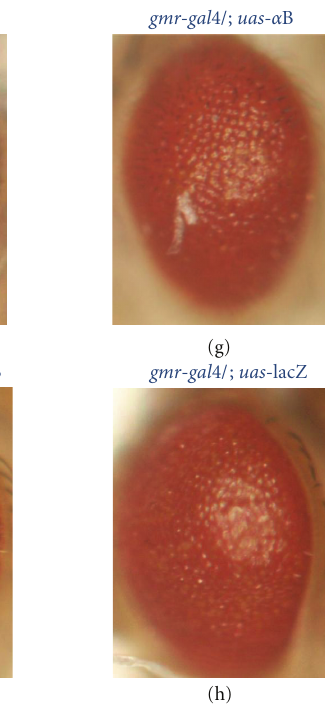
Figure 2: Suppression of compound eye degeneration by coexpression of α B-crystallin in the Q92-expressing flies. Light microscopic images of the adult compound eyes of the polyQ lines expressing only one Q92 peptide (a) or 2xQ92 peptide (d) under control of the gmr promoter. (c, f) Transgenic flies coexpressing Q92 peptides and α B-crystallin ( gmr-gal4; gmr-Q92/ + ; uas- α B-crystallin-HA ). (b, e) Transgenic flies coexpressing Q92 peptides and control LacZ protein ( gmr-gal4; gmr-Q92/ + ; uas-LacZ ). (g) Transgenic flies expressing α B-crystallin alone ( gmr-gal4; uas- α B-crystallin-HA ). (h) Transgenic flies expressing lacZ alone ( gmr-gal4; uas-LacZ ). Magnification x